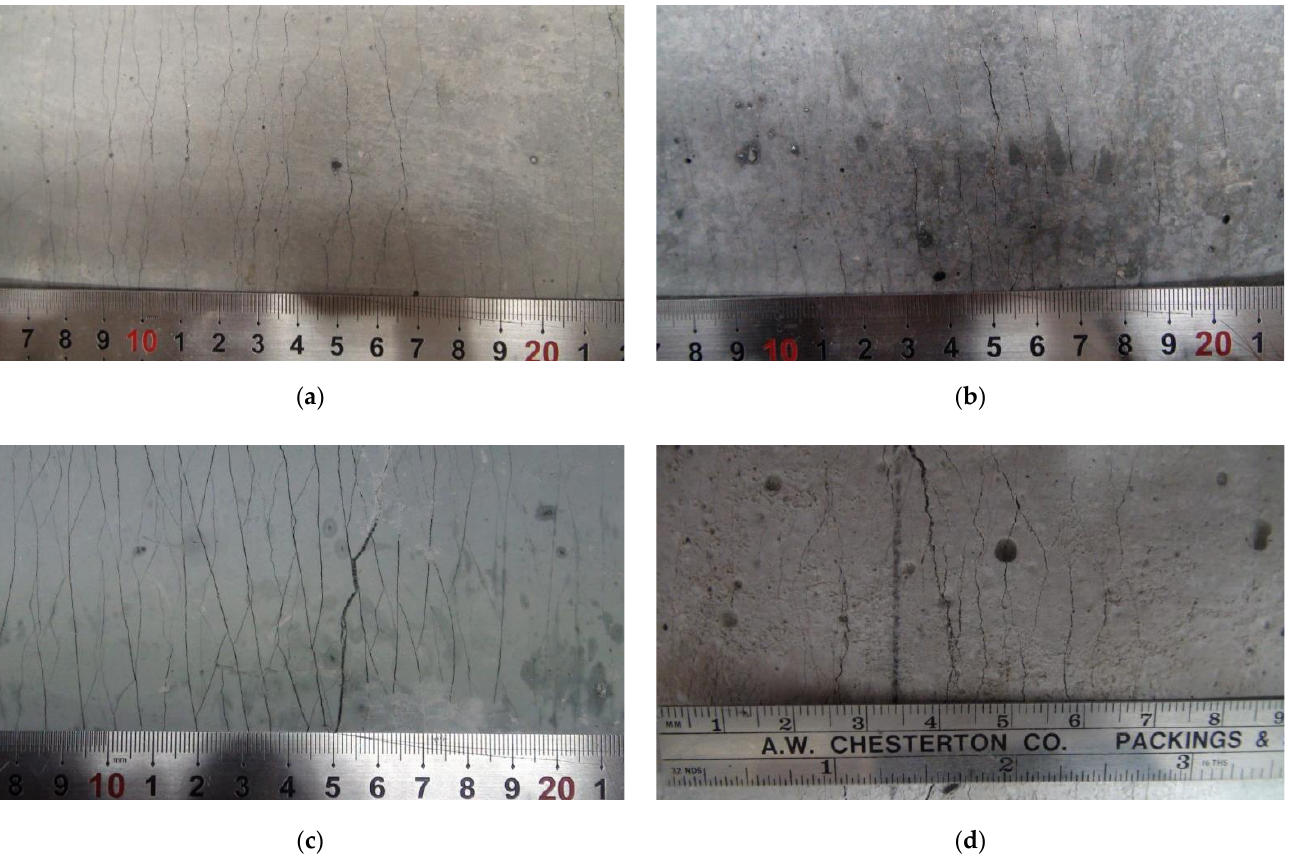
Figure 11. Multiple microcracks in bending panel: ( a ) ASFC100 (PVA 1.00 vol.%); ( b ) ASFC125 (PVA 1.25 vol.%); ( c ) ASFC150 (PVA 1.50 vol.%); ( d ) ASFC200 (PVA 2.00 vol.%). Table 7. Bending test results.